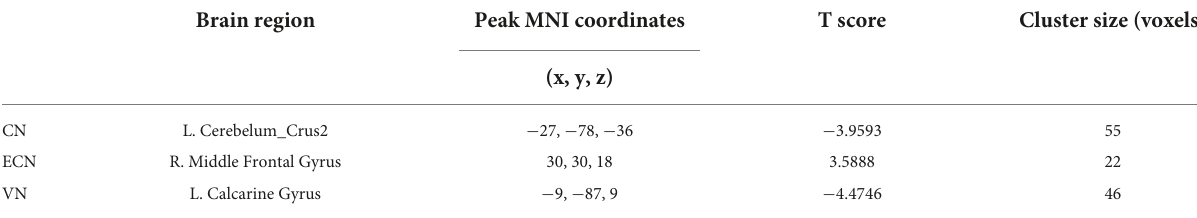
TABLE 2 Brain regions with significant difference connectivity within RSNs between patients and healthy